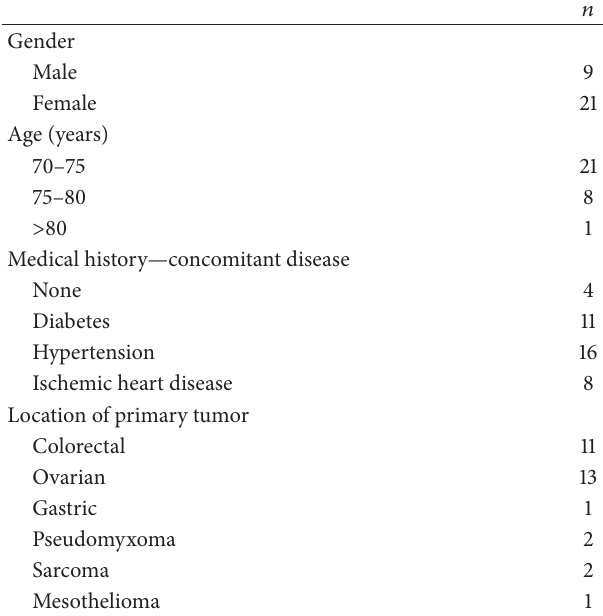
Table 1: Patient characteristics ( 𝑛 = 30